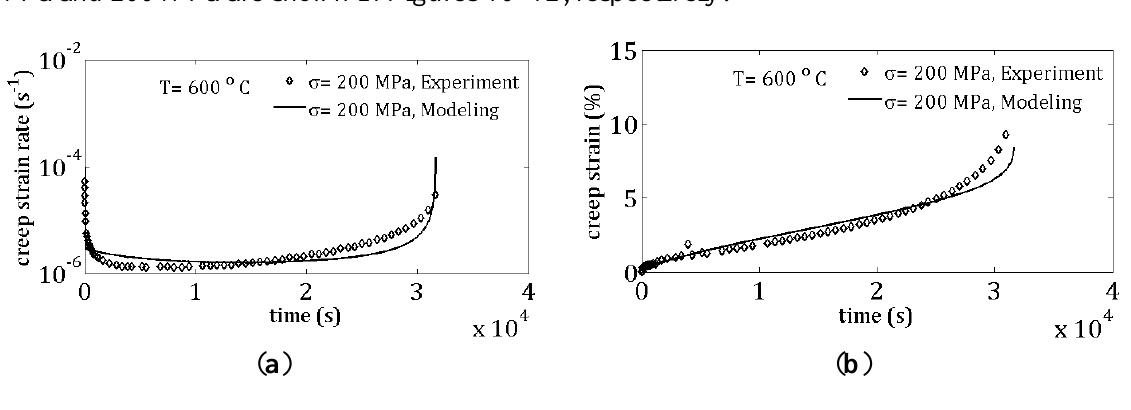
Figure 9. Creep results from experiments and finite element simulation for 200 MPa and 600 °C: ( a ) creep strain rate versus time; and ( b ) true creep strain versus time.